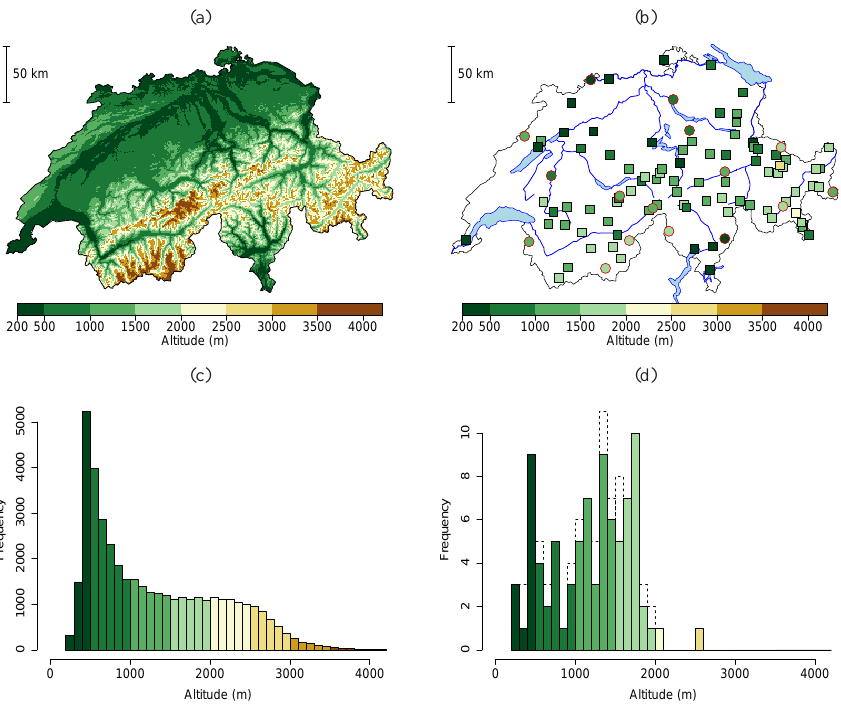
Fig. 2. Upper row: (a) Elevation map of Switzerland and (b) station locations. Lower row: (c) Histogram of elevations in Switzerland in a 1 km grid spacing and (d) of the stations. Color indicates elevation in meters above sea level. Among the 100 stations, 16 are excluded from the analysis for validation (red circles in the right map corresponding to dashed part of the right histogram).